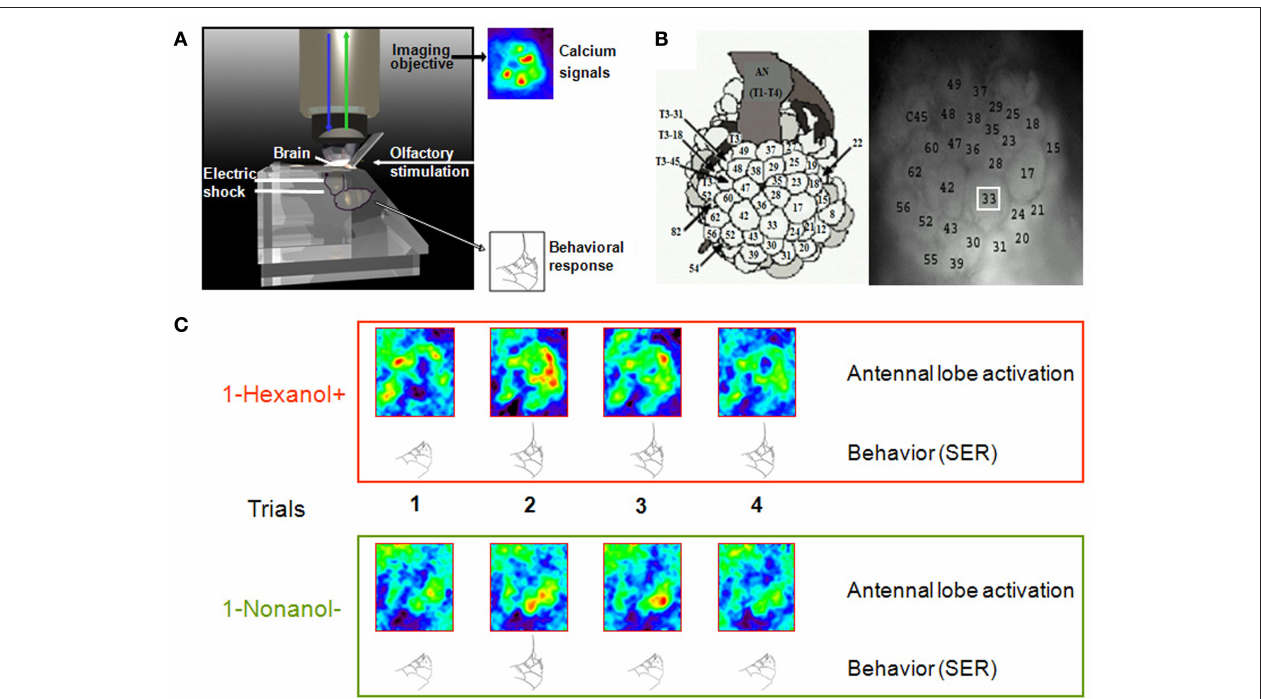
allowing recognition of individual glomeruli. The white square is an example of the area in which calcium signal amplitude is calculated for each